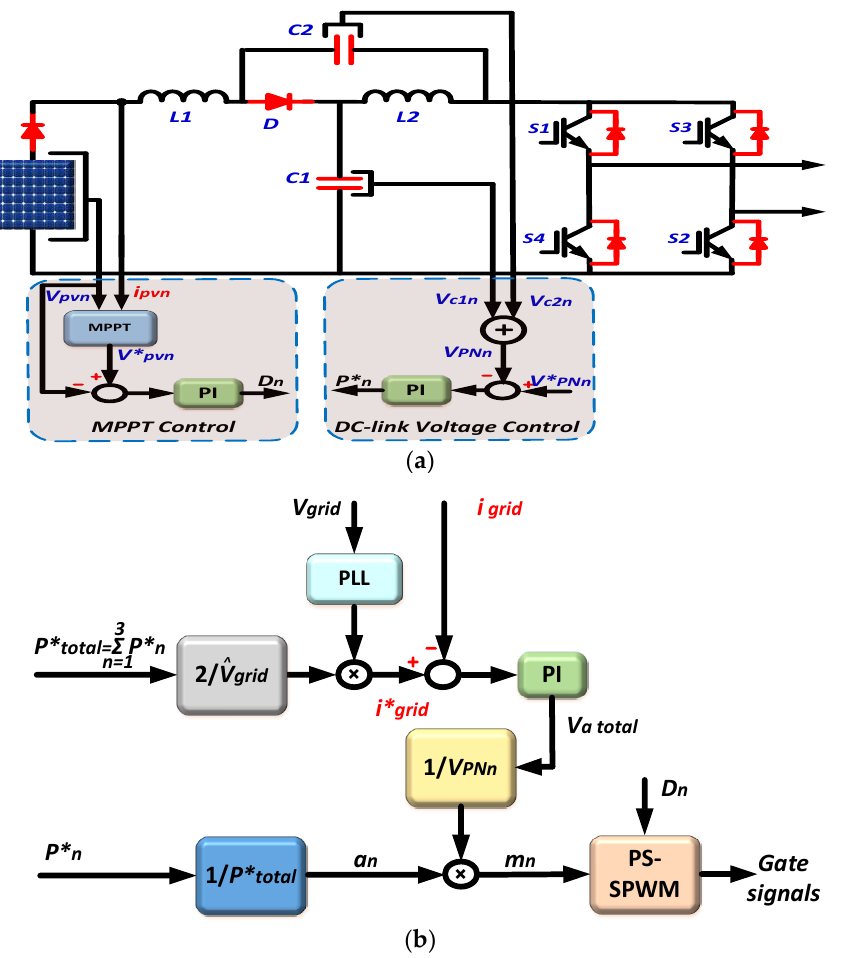
Figure 19. The control scheme for qZS-CMI based PV power system. ( a ) Control method of each qZSI module, ( b ) power control of the whole system [156].